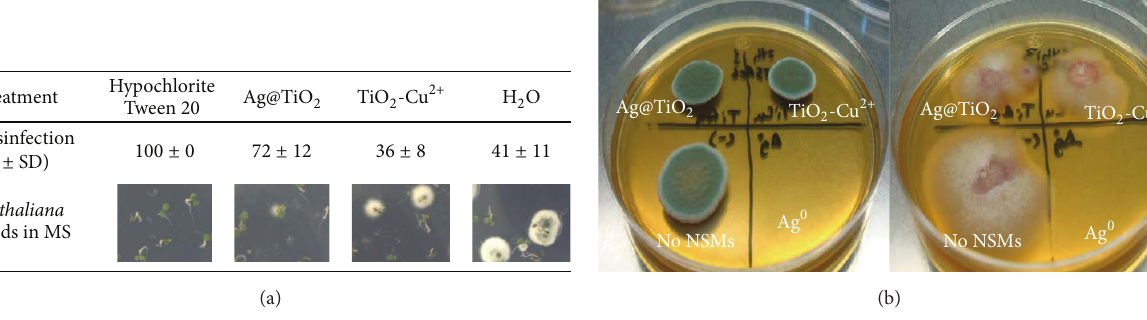
Figure 3: Seeds and their contaminants treated with Ag@TiO 2 and TiO 2 -Cu 2+ . (a) Treatment of A. thaliana seeds with 10mg/mL of NSMs prior to cultivation in vitro ; (b) fungal contaminants seeds exposed to 10mg/mL of NSMs; each treatment was performed in